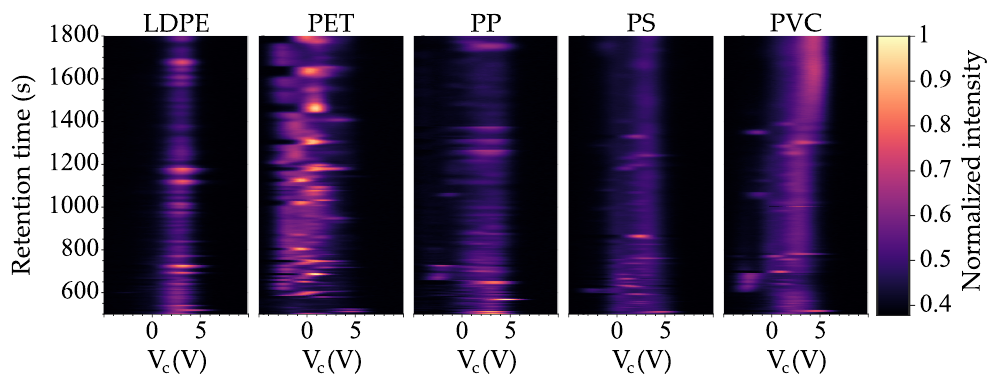
Figure 4. Representative Py/GC-DMS data for five plastic samples, LDPE, PET, PP, PS, and PVC. Compensation voltage (V C ) is shown on the horizontal axis and ion intensity at the electrometer (V) is represented with the headmap. Distinct signatures are observed for each